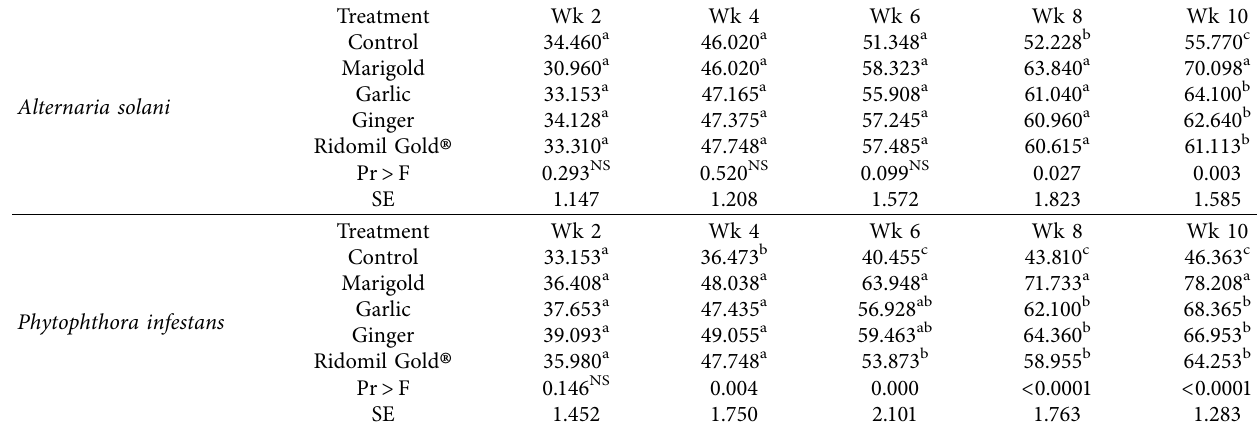
Table 5: Effects of essential oils on height of inoculated tomato plants.